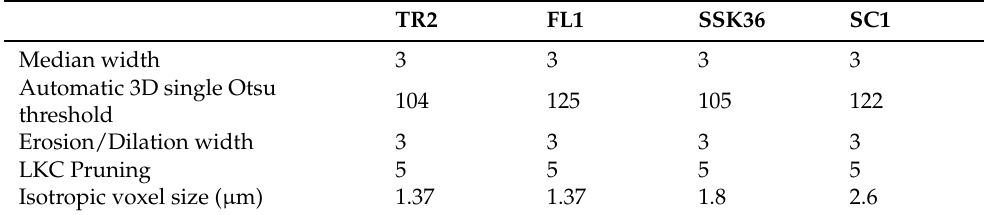
Table 2. Parameters of the PyPore3D protocol used on the samples: TR2, Fl1, SSK36 and SC1. TR2 FL1 SSK36 SC1 Median width 3 3